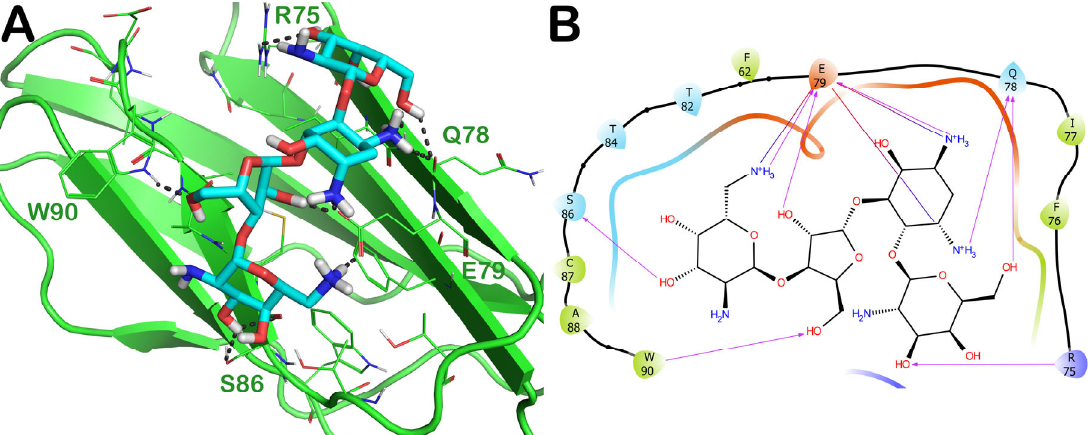
Figure 5. ( A ) Docking output of compound ZINC000060183170 (cyan sticks) within the surface of the irisin monomer (PDB ID 4LSD, green cartoon) involved in the dimerization process. The key interacting residues are represented by lines. The H bonds are depicted as dotted lines. Non-polar hydrogen atoms were removed for the sake of clarity. ( B ) A 2D representation of the contacts established by ZINC000060183170 within the irisin monomer interface. Images were prepared using PyMOL and the Ligand-Interaction Diagram application implemented in Maestro.